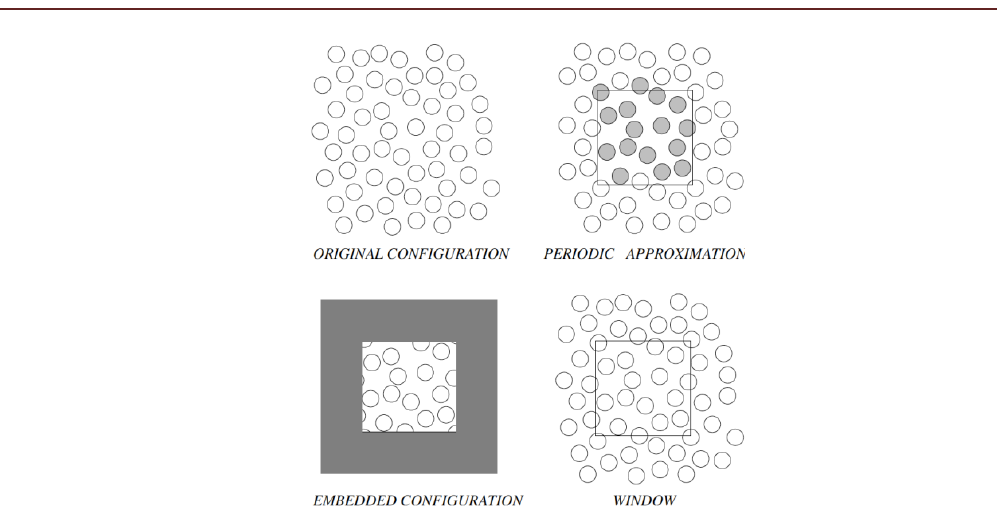
Figura 5: Tecniche di modellazione basate su microstrutture discrete: PMA, ECA e windowing approach (SVEs) [2].